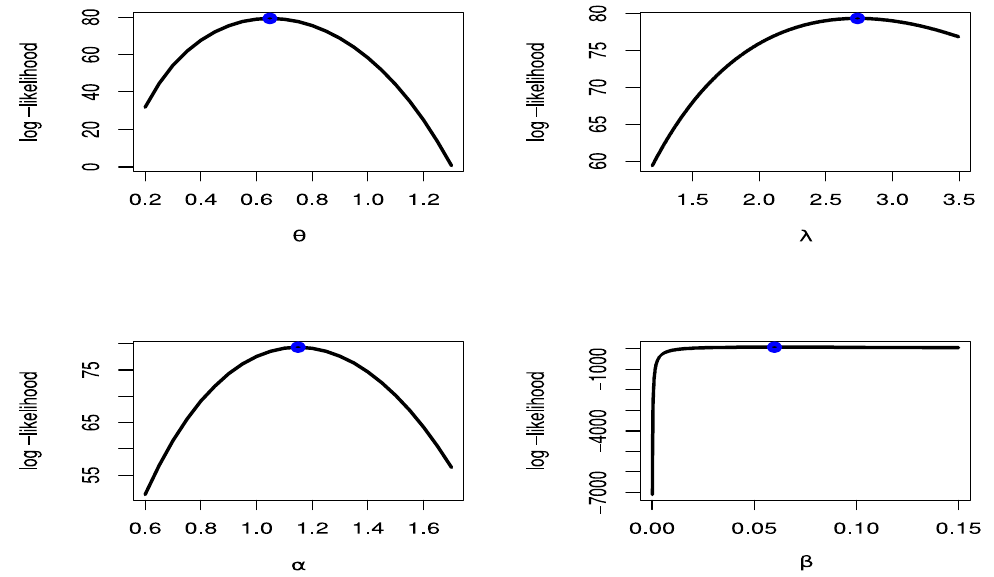
Figure 18. Likelihood profile for parameters of TCPWL distribution for COVID-19 data.